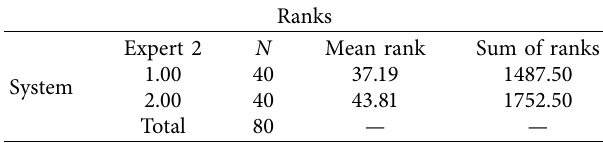
Table 8: SPSS software outputs regarding the similarity of software output and expert opinions.